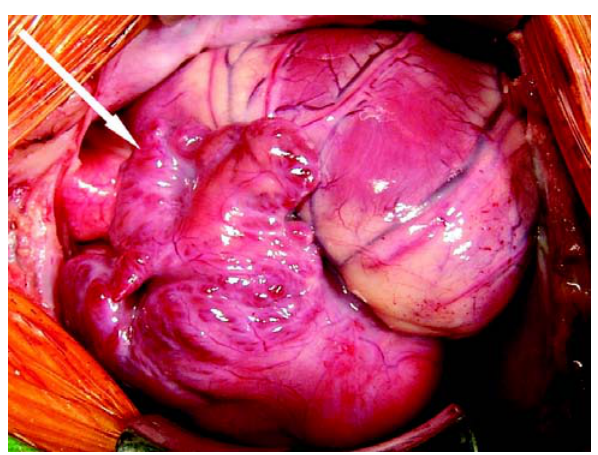
Fig. 2 – Isomerismo atrial esquerdo